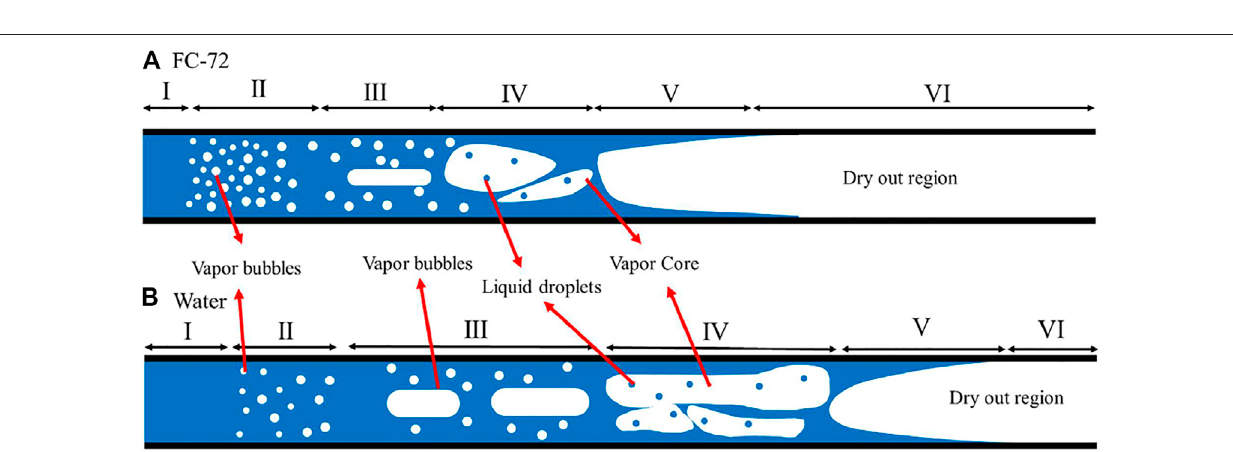
Frontiers in Mechanical Engineering |